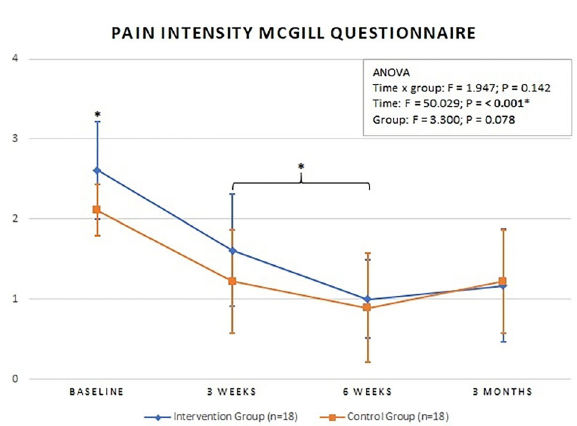
Figure 2. Mean pain intensity values at baseline, 3 weeks, 6 weeks, and 3 months. Intervention Group: completed cases using the intention-to-treat analysis. *P o 0.05 for time (ANOVA).